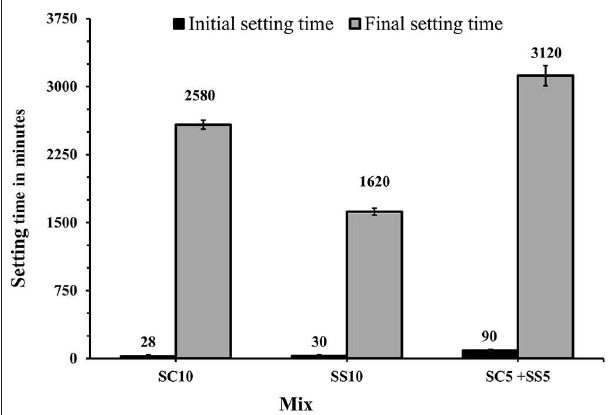
FIGURE 1 | Grading curve of combined coarse and fine aggregates.